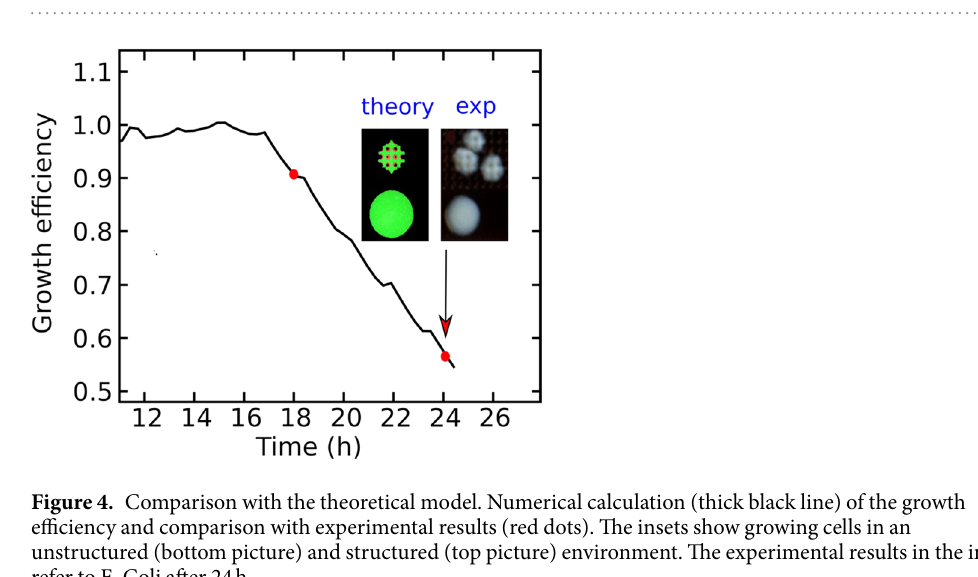
Figure 3. C. Albicans morphology. Image of hyphae initial formation on AG ( a,c ) and AGO-P ( b,d ). Dashed red lines represent the bleached areas of the hydrogel. When C. Albicans colonies meet the pattern on AGO-P, cells lose their ordered structure completely and fill the circular holes.